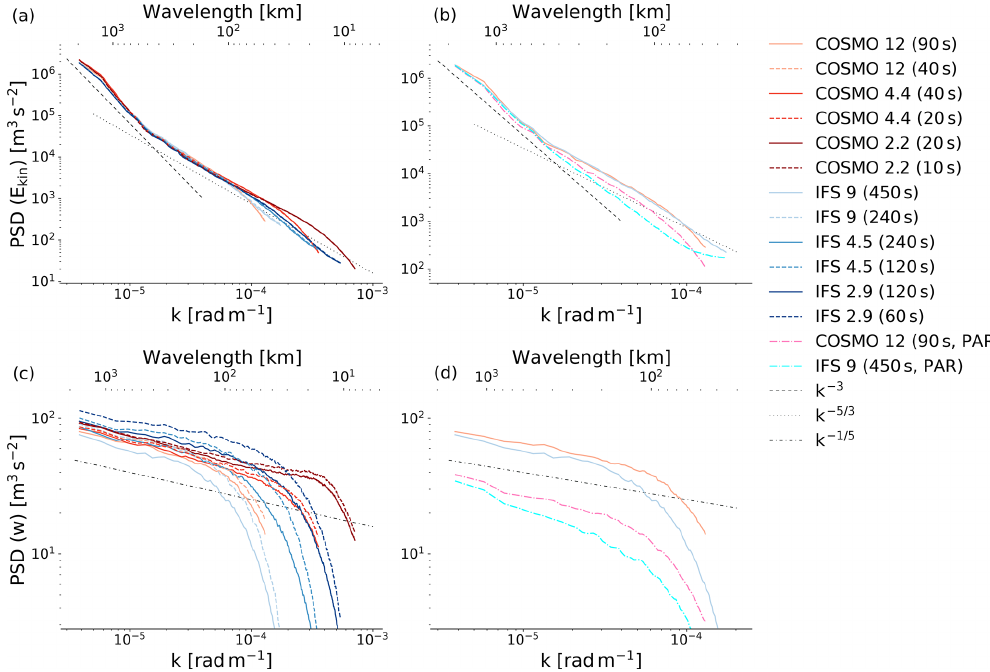
Figure 8. Power spectral density (PSD) plots for horizontal kinetic energy and w at 500hPa (a–d) . Panels (a) and (c) show PSDs of all runs with explicit deep convection. Panels (b) and (d) show PSDs for the coarser runs with parameterized (PAR) and explicit deep convection. Data points for wavelength smaller than 4 (cid:49)x or larger than L/ 2, where L is the domain width, have been cut off. Note the different scales on the vertical and horizontal